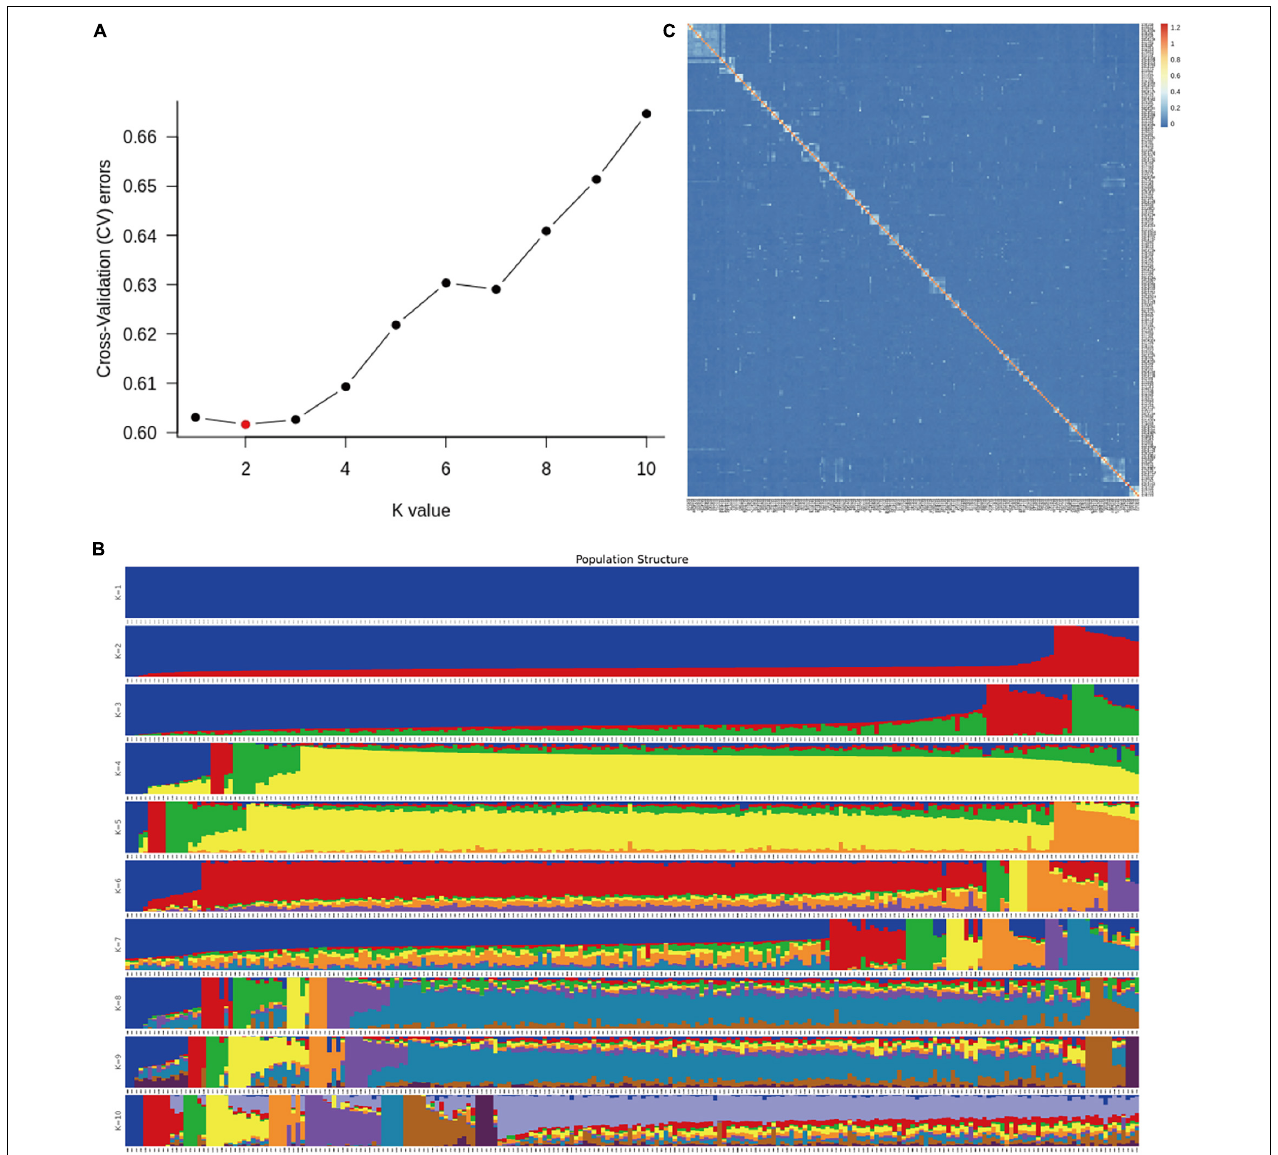
FIGURE 1 | Population structure analysis in the G1 and G2 generations nucleus herd of Hu sheep. (A) Population structure of 226 Hu sheep with optimal K = 2; (B) Population structure of 226 Hu sheep with K from 1 to 10; (C) Kinship plot of 226 Hu